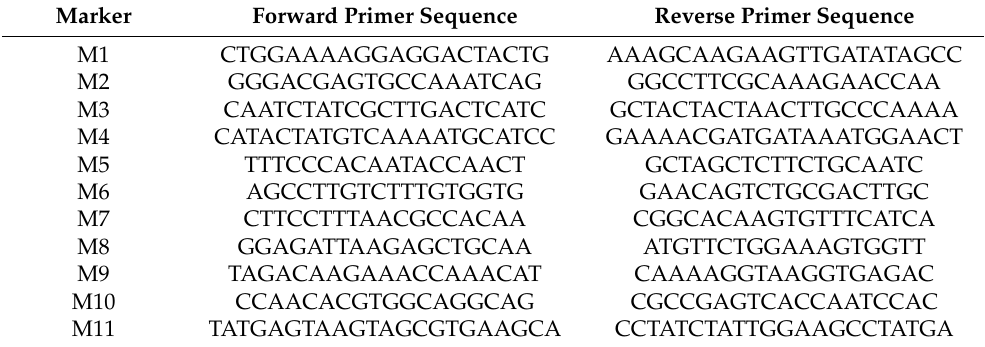
Table 2. The molecular markers used for mapping ZmGHT1 in this study.